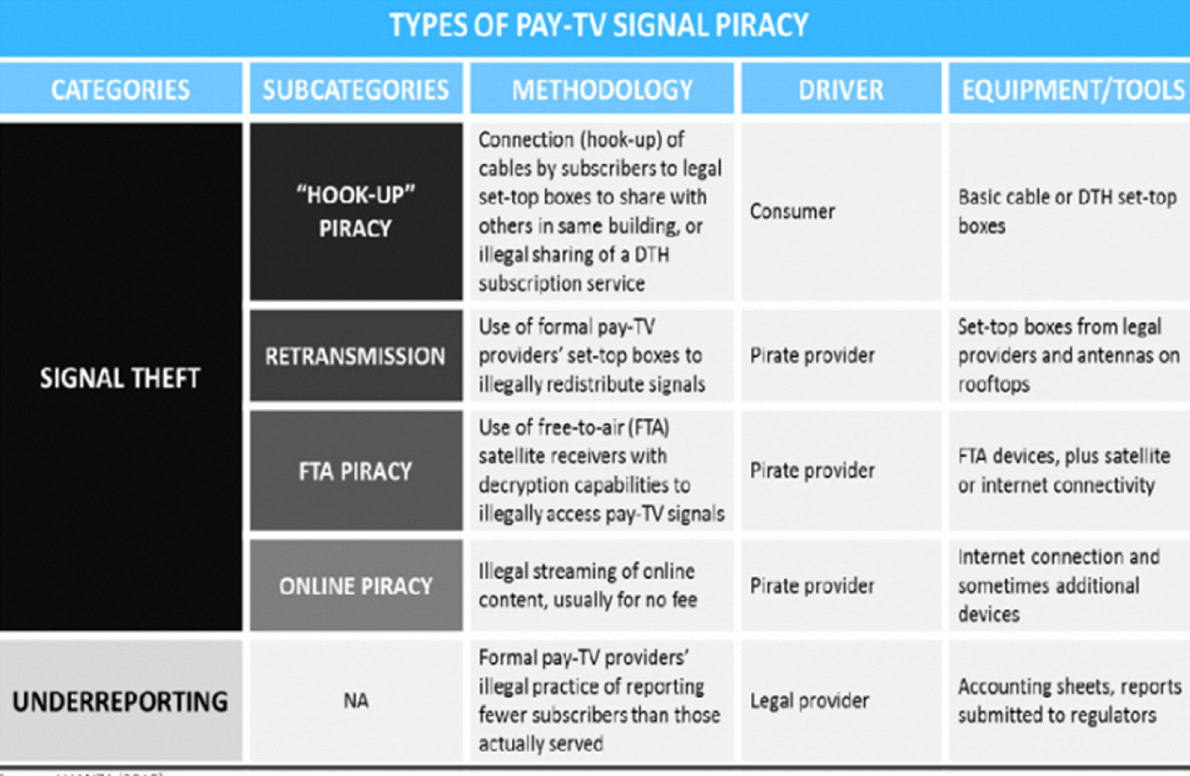
Figure 2: Types of pay signal